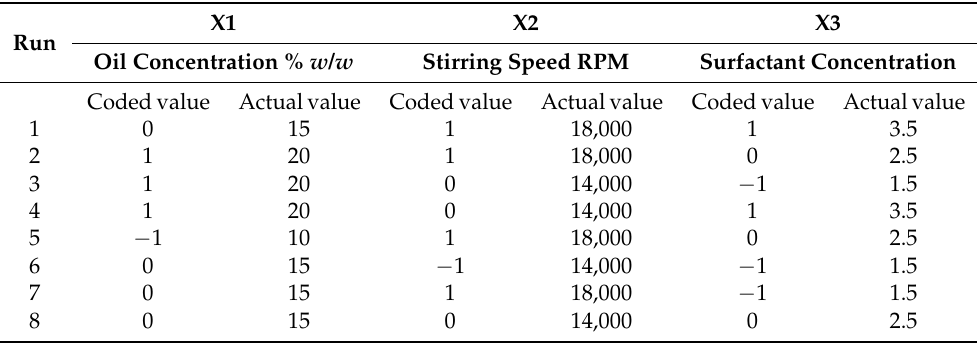
Table 3. Different sets of experiments for 15 trails of formulations with coded and actual